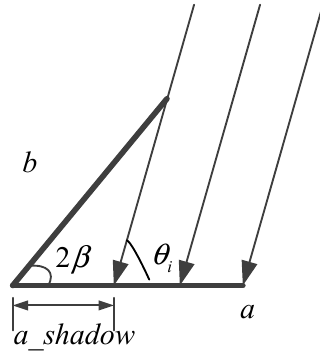
Figure 11. Shadow effect of plane a .